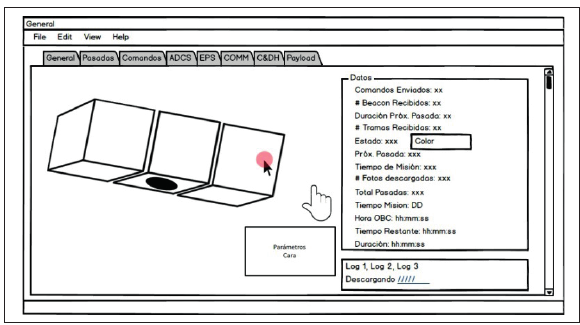
figure 16. GUI design for the GSCM&C main window.